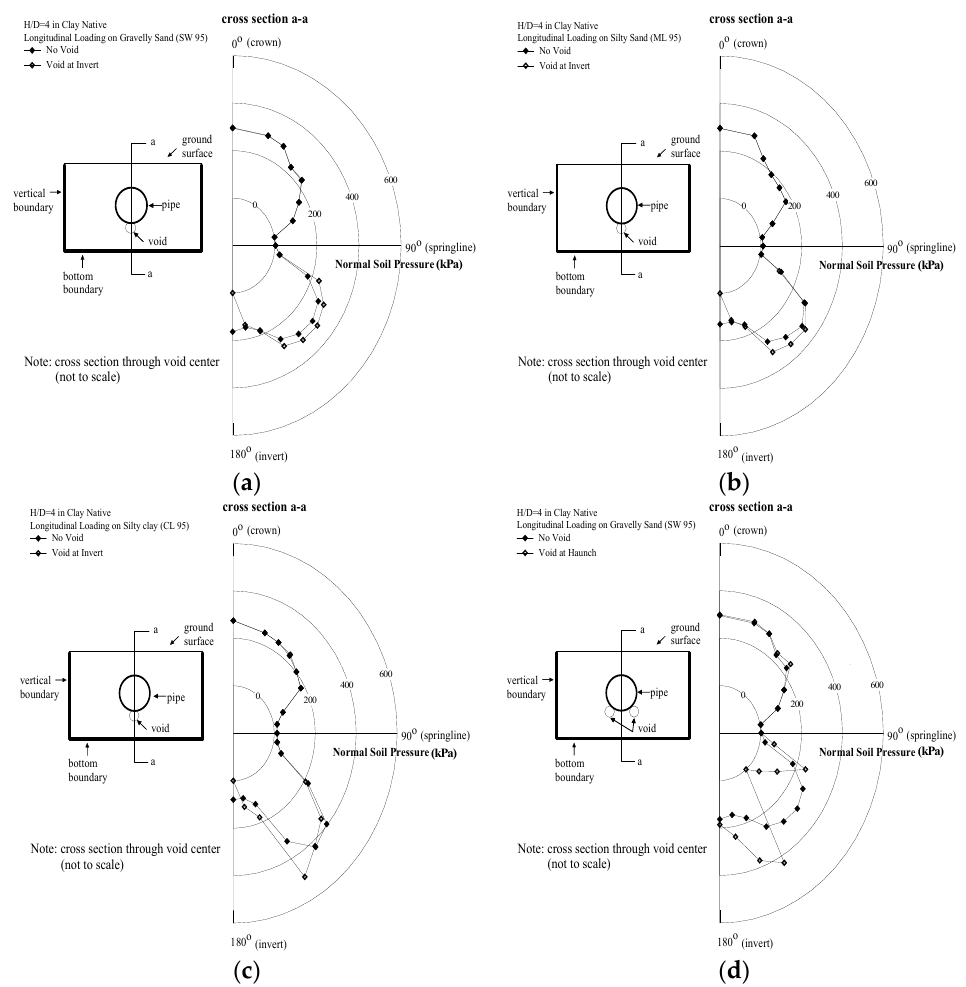
Figure 9. Comparison of normal soil pressure distributions with and without voids: ( a – c ) void at the invert and ( d ) void at the haunch.